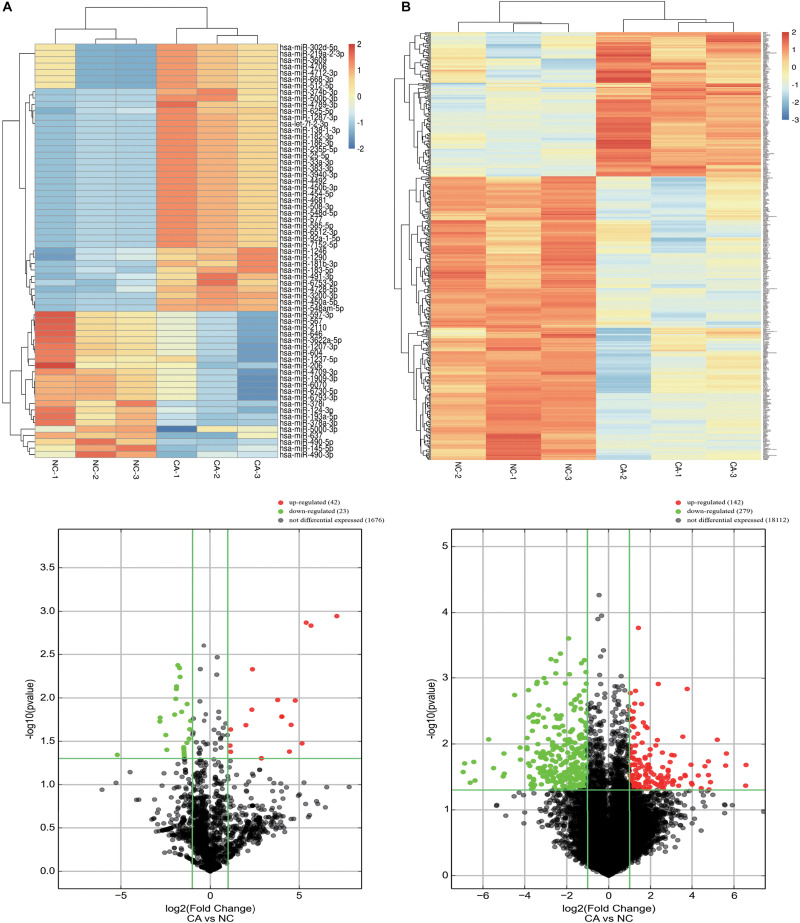
Identification of DE miRNAs and mRNAs in CRC. (A) DE miRNAs between CRC cancer and paired adjacent normal tissues; (B) DE mRNAs between CRC cancer and paired adjacent normal tissues. Up: heat maps; Down: volcano plots. Differentially expressed miRNAs and mRNAs were mined through the following criteria: | Fold change| ≥ 2 and P < 0.05.